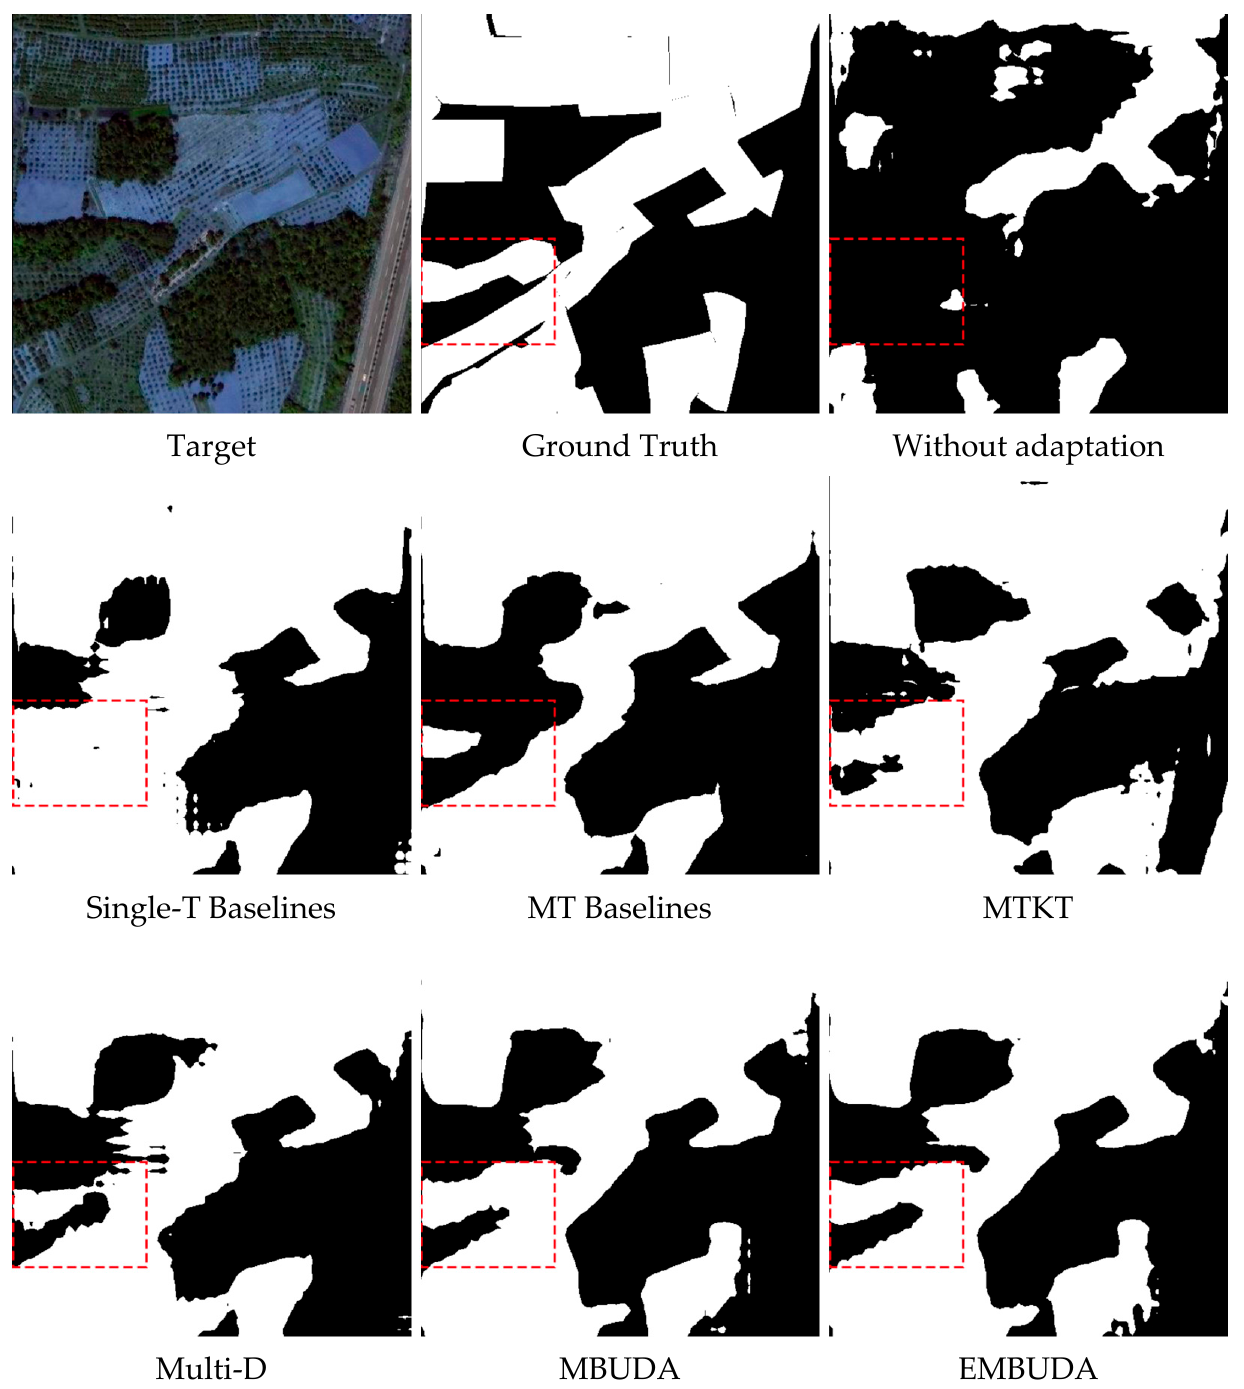
Figure 8. Outputs of orchard area segmentation in Dataset XT1 when adapting from Dataset ZG to Dataset CY, Dataset XT1, and Dataset XT2.